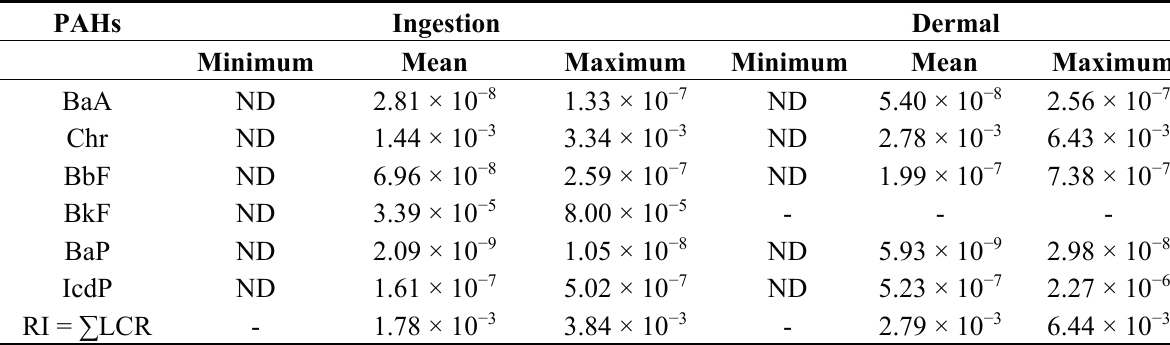
Table 5. Carcinogenic risk of PAHs.